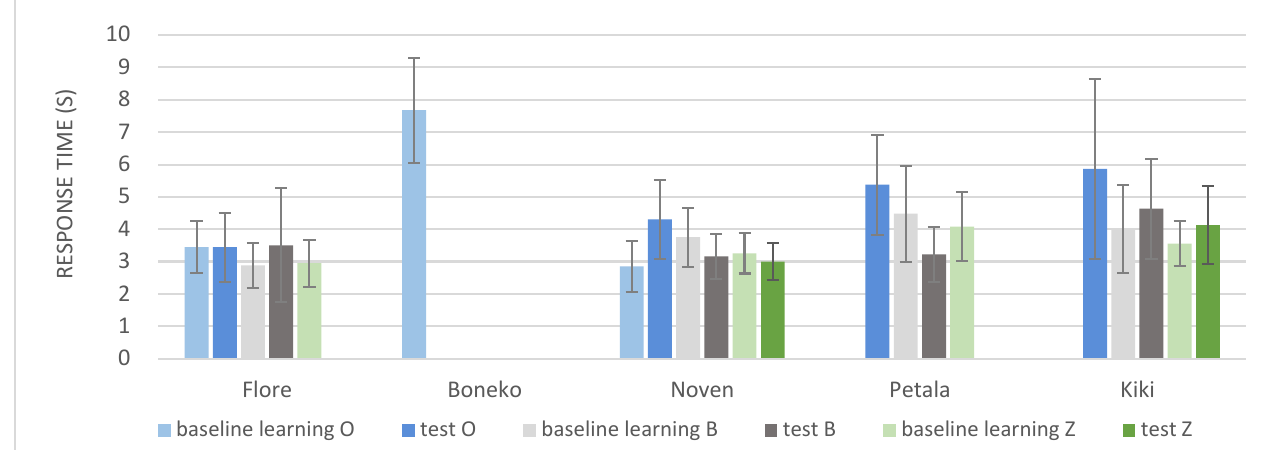
Figure 8. Response times of each horse participant in each task. Some baseline and test phase data